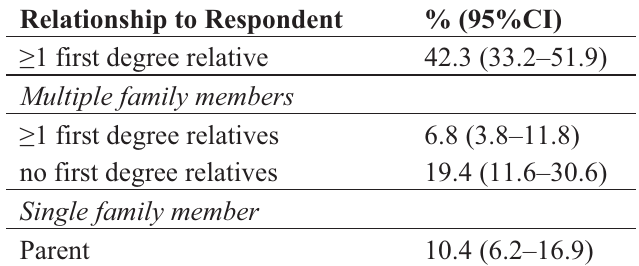
Table 3. Percent distribution of relationship of respondent to family member who experienced sudden cardiac death of the young (n = 190), 2007 Michigan Behavioral Risk Factor Survey